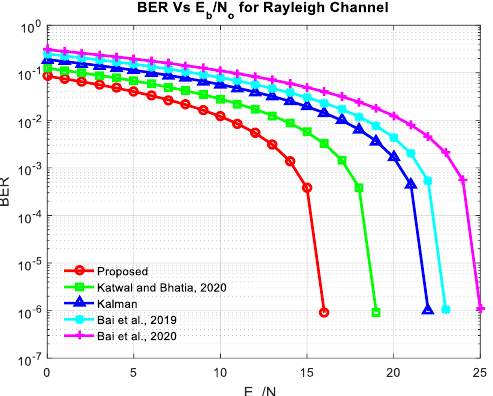
Figure 12. BER vs. E